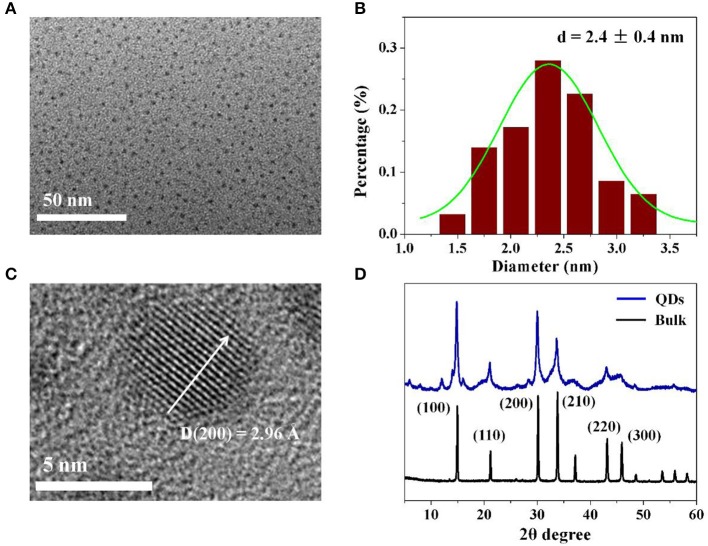
(A) TEM image of as-synthesized colloidal CH3NH3PbBr3 QDs. (B) Statistical analysis of (A). (C) High resolution TEM image of single CH3NH3PbBr3 QD. (D) XRD spectra of colloidal CH3NH3PbBr3 QDs and the corresponding CH3NH3PbBr3 bulk.